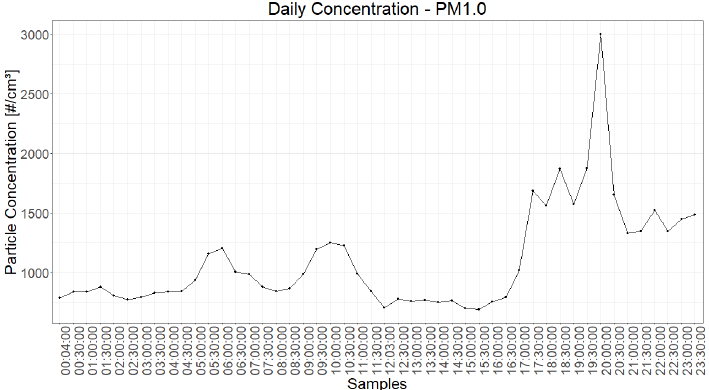
Figure 1. The PM1.0 particle concentration in the air, as recorded by the SPS30 sensor (19 April 2020). Figure 2 presents the PM1.0 and PM2.5 particle masses and concentrations over the course of seven months, from October 2019 to April 2020. Figure 3 presents the weekly particle concentration averages. From 23 December to 3 January, the particle sensor was not functional, so there were no data collected during this short period.